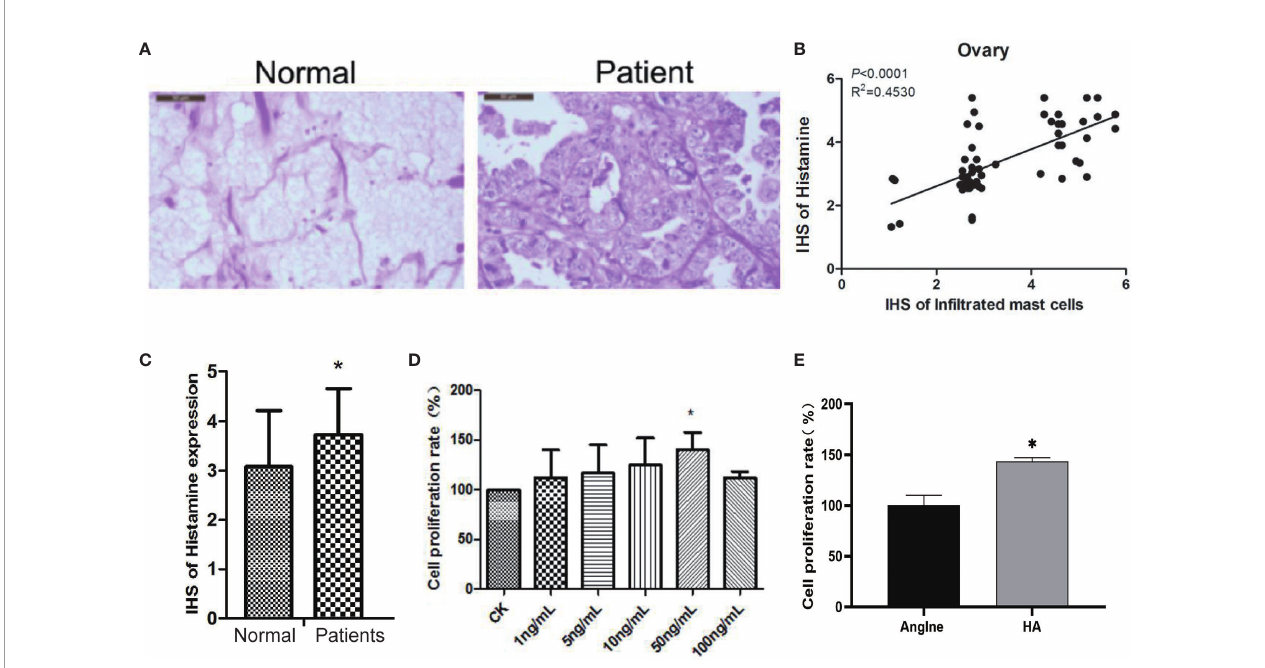
FIGURE 2 | Histamine released by mast cell degranulation stimulates the proliferation of ovarian cancer cells. (A) HE staining of normal ovarian tissue (left) and ovarian cancer tissue (right). (B) Correlation between mast cell in fi ltration and histamine release in ovarian cancer tissue. (C) Histamine release levels in normal ovarian and ovarian cancer tissues, * P < 0.05 (compared to normal tissues). (D) OVCAR-3 cell proliferation after treatment with different concentrations of histamine. (E) Anglne cell proliferation rate after treatment with histamine at a concentration of 50 ng/mL. * P < 0.05 (compared to untreated Anglne cell